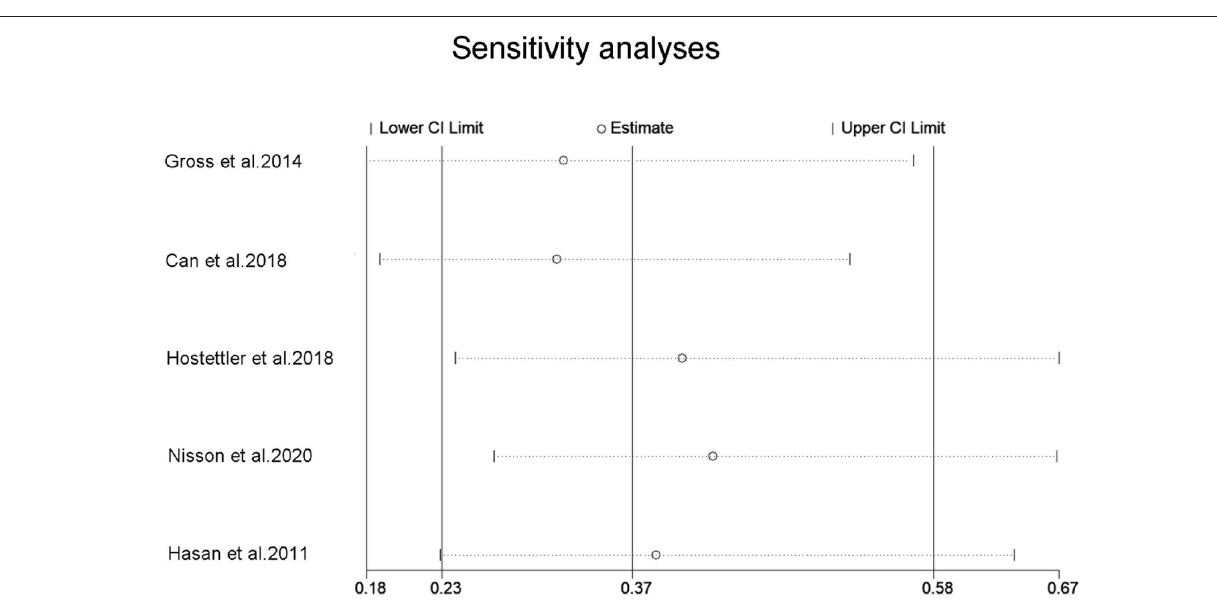
FIGURE 4 | Sensitivity analysis for an association between aspirin use and risk of subrachnoid hemorrhage. OR, odds ratio; CI, confidence